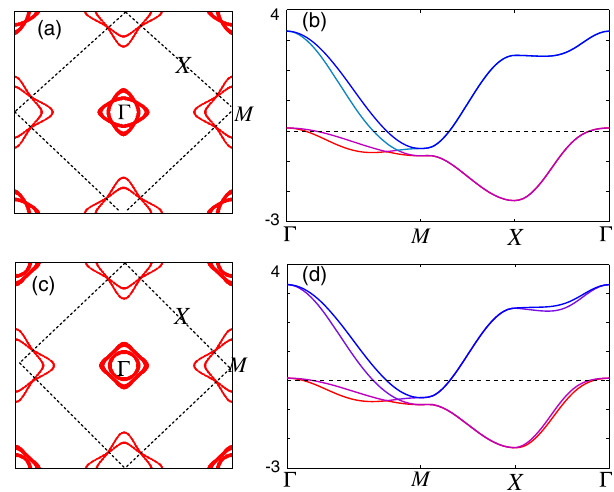
FIG. 5. Typical Fermi surfaces (a) and band dispersions ¼ 0 and parameters t ¼ (b) resulting from Eq. (10), with t 1 s c ¼ (cid:2) 0 : 03 , t ¼ 0 : 3 , t ¼ 0 : 6 , t ¼ 0 : 05 , t ¼ (cid:2) 0 : 05 , 0 : 4 , t 1 d 2 s 2 d 3 s 3 d ¼ and (cid:5) ¼ (cid:2) 0 : 3 . (c),(d) show the corresponding results when t c 0 : 02 is used in Eq. (7) with the same parameter settings. The y axis for (b),(d) is in units of E(ev).